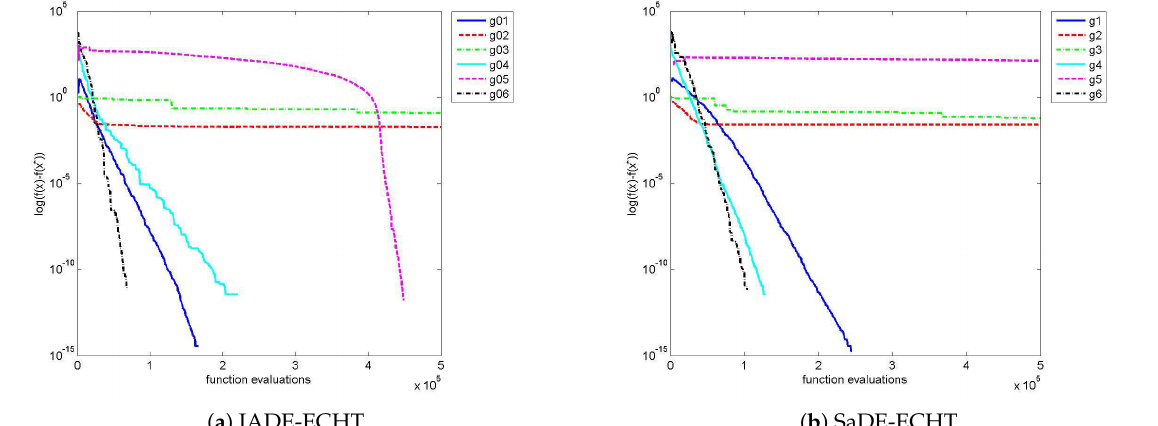
Figure 3. Convergence comparison of JADE-ECHT and SaDE-ECHT for